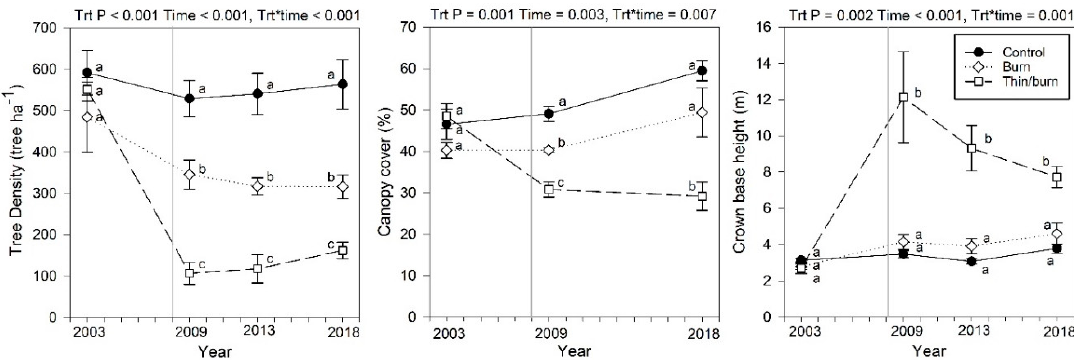
Figure 2. Forest structure (trees taller than 137 cm and >2.5 cm dbh) through time for both treatments and control. Bars represent 1 standard error of the mean ( n = 4). The vertical line denotes when all treatments were completed (2008). Data comparisons are among treatments and different letters denote a significant treatment effect within a year ( p ≤ 0.05).